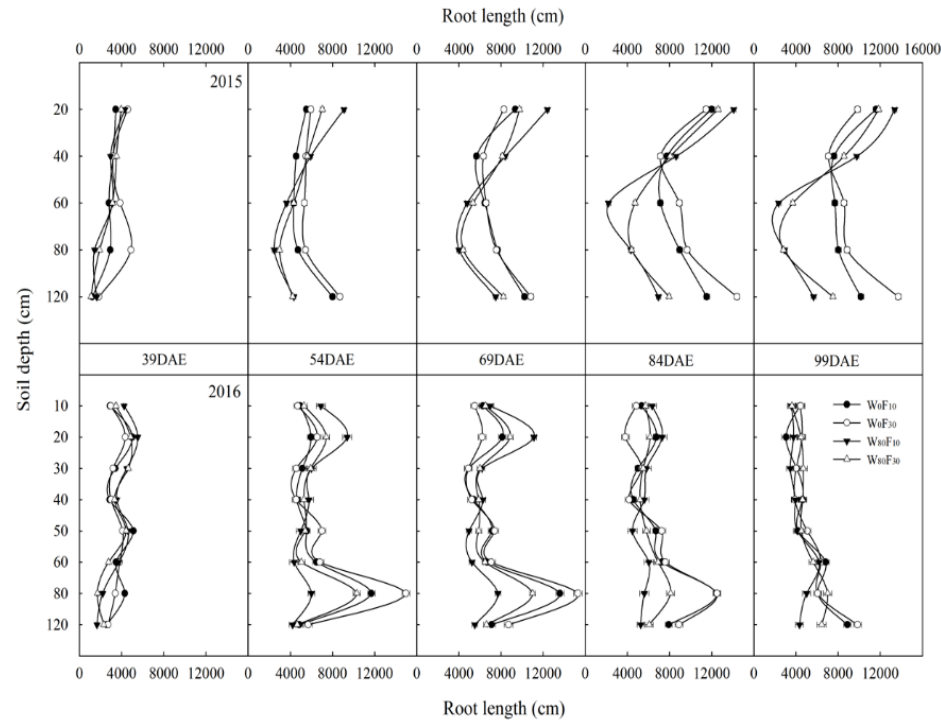
Figure 3. Changes in the root length in different vertical soil layer (from 0 to 120 cm soil layer) at pre-sowing irrigation (W 80 ) or no pre-sowing irrigation (W 0 ) and basal surface fertilization (F 10 ) or deep (F 30 ) application with the days after emergence (DAE).